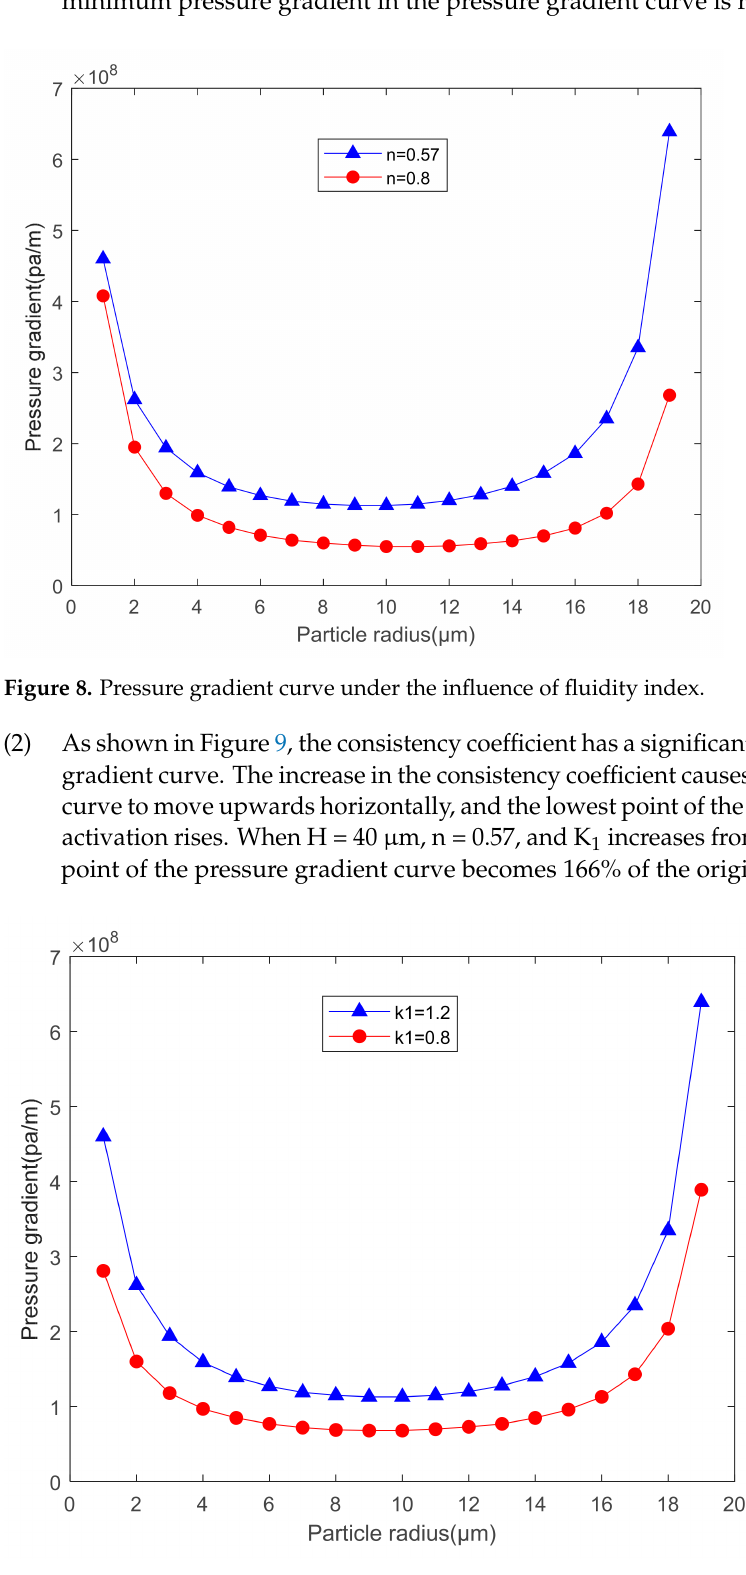
Figure 9. The effect of consistency coefficient on pressure gradient